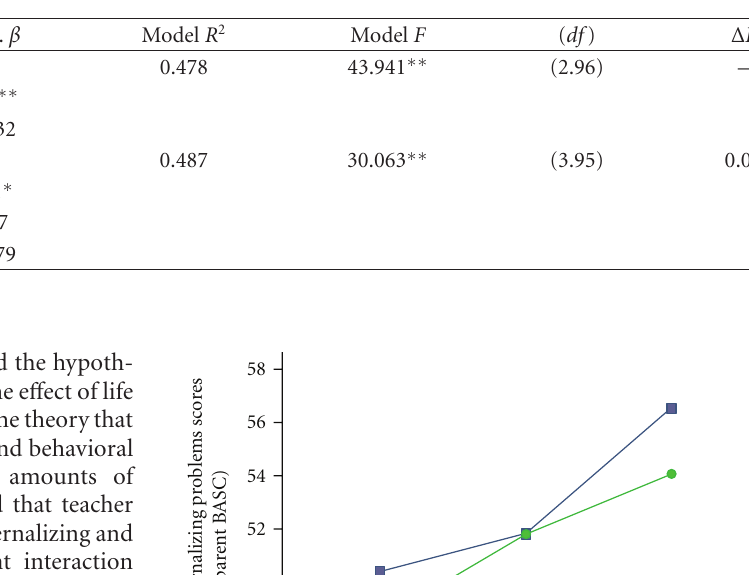
Table 2: Hierarchical regression—internalizing problems (basc) as criterion.